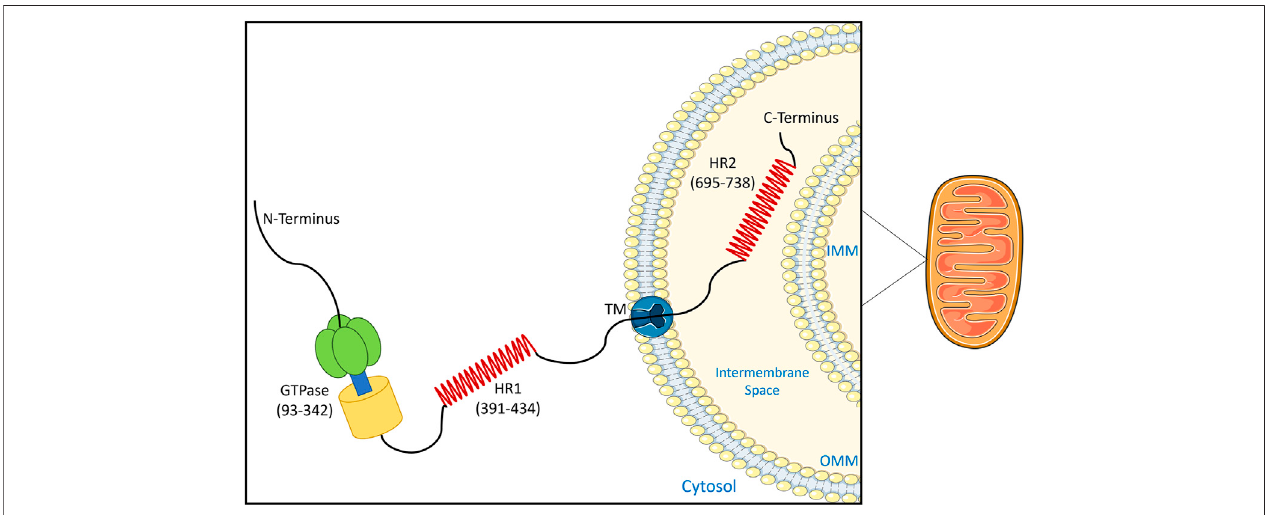
FIGURE 3 | Topology of MFN2. This schematic shows the domain arrangement and spatial structure of the MFN2 protein on the mitochondrial outer membrane. The 757 amino acid protein contains a GTPase domain and heptad repeat domain (HR1) exposed to the cytosol, and a second heptad repeat domain (HR2) that localizes to the mitochondrial intermembrane space. The schematics used in the fi gures were taken from Servier Medical Art by Servier.